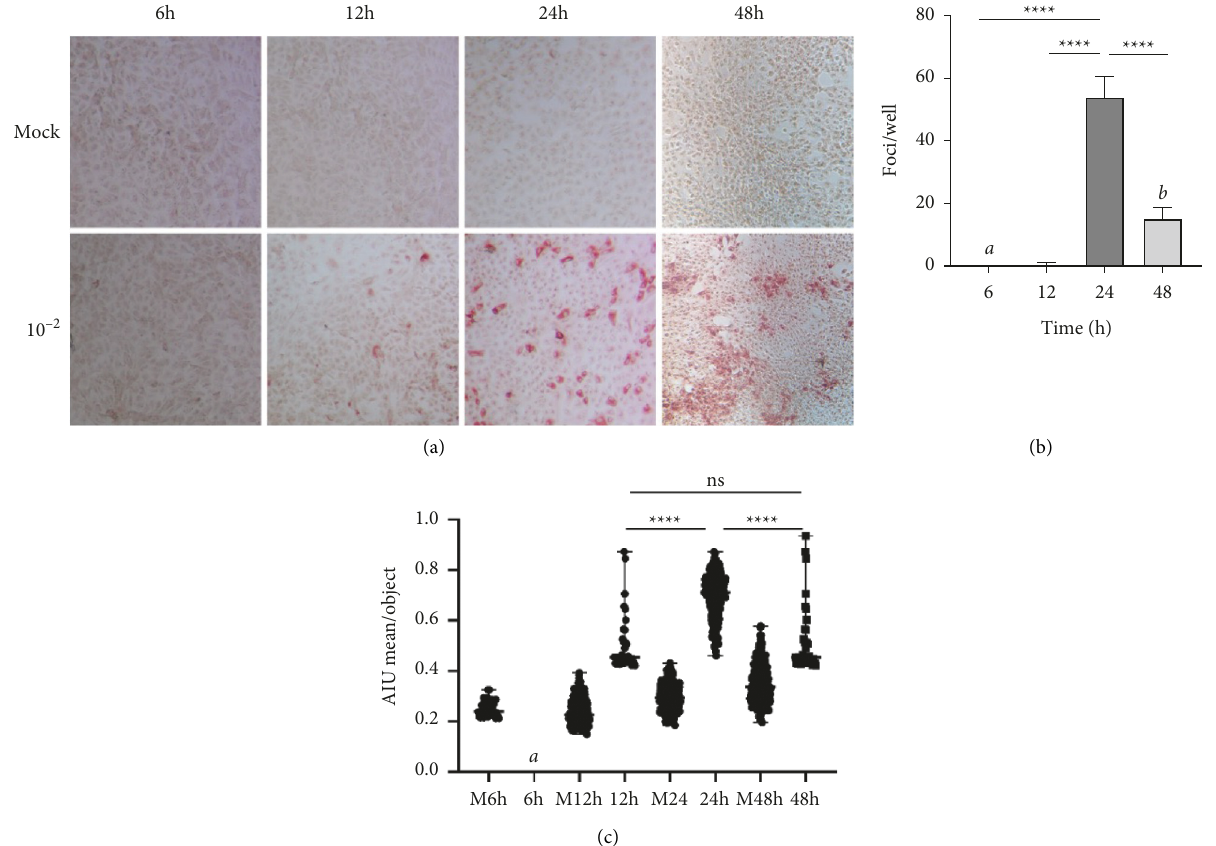
Figure 3: Twenty-four hours was the optimal time for performing the ZIKV focus-forming assay. (a) Comparison of the FFUs at different times in the 10 − 2 dilution. (b) Number of FFUs/well counted at the 10 − 4 dilution at each time postinfection. The mean ± standard deviation is shown. ∗∗∗∗ p < 0 . 0001, Tukey’s test. (c) Arbitrary intensity unit (AIU) values found in the FFUs at each postinfection time, as evaluated by the free software CellProfiler TM . The median and range are displayed. ∗∗∗∗ p < 0 . 0001, Dunn’s test. n � 2 experiments in triplicate. a Not detectable. b Unreliable foci count due to the formation of clusters of infected cells. M: